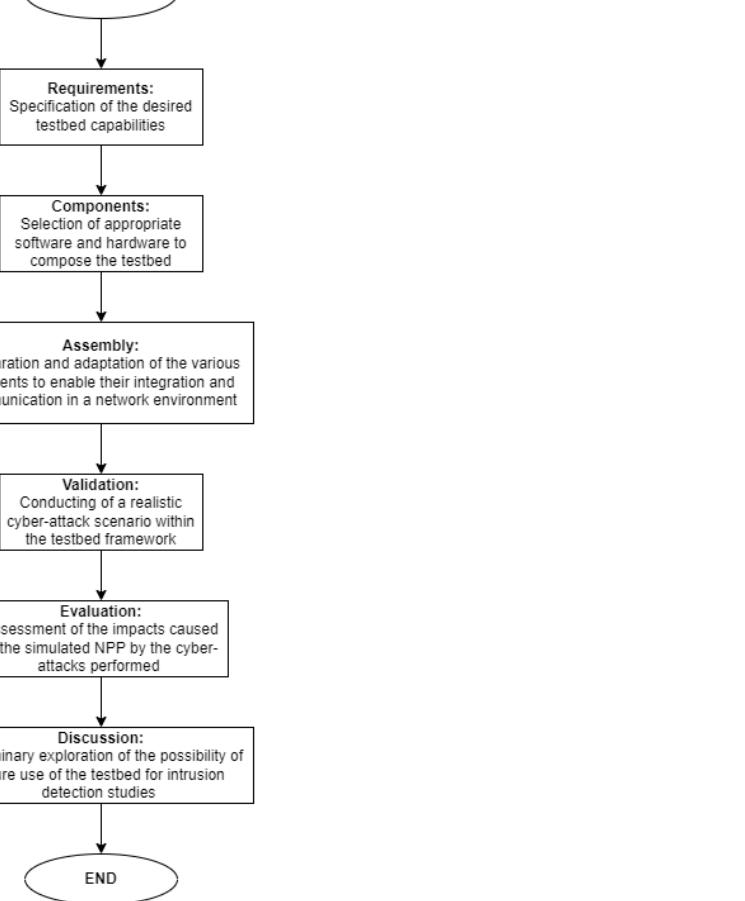
Figure 1. Methodological